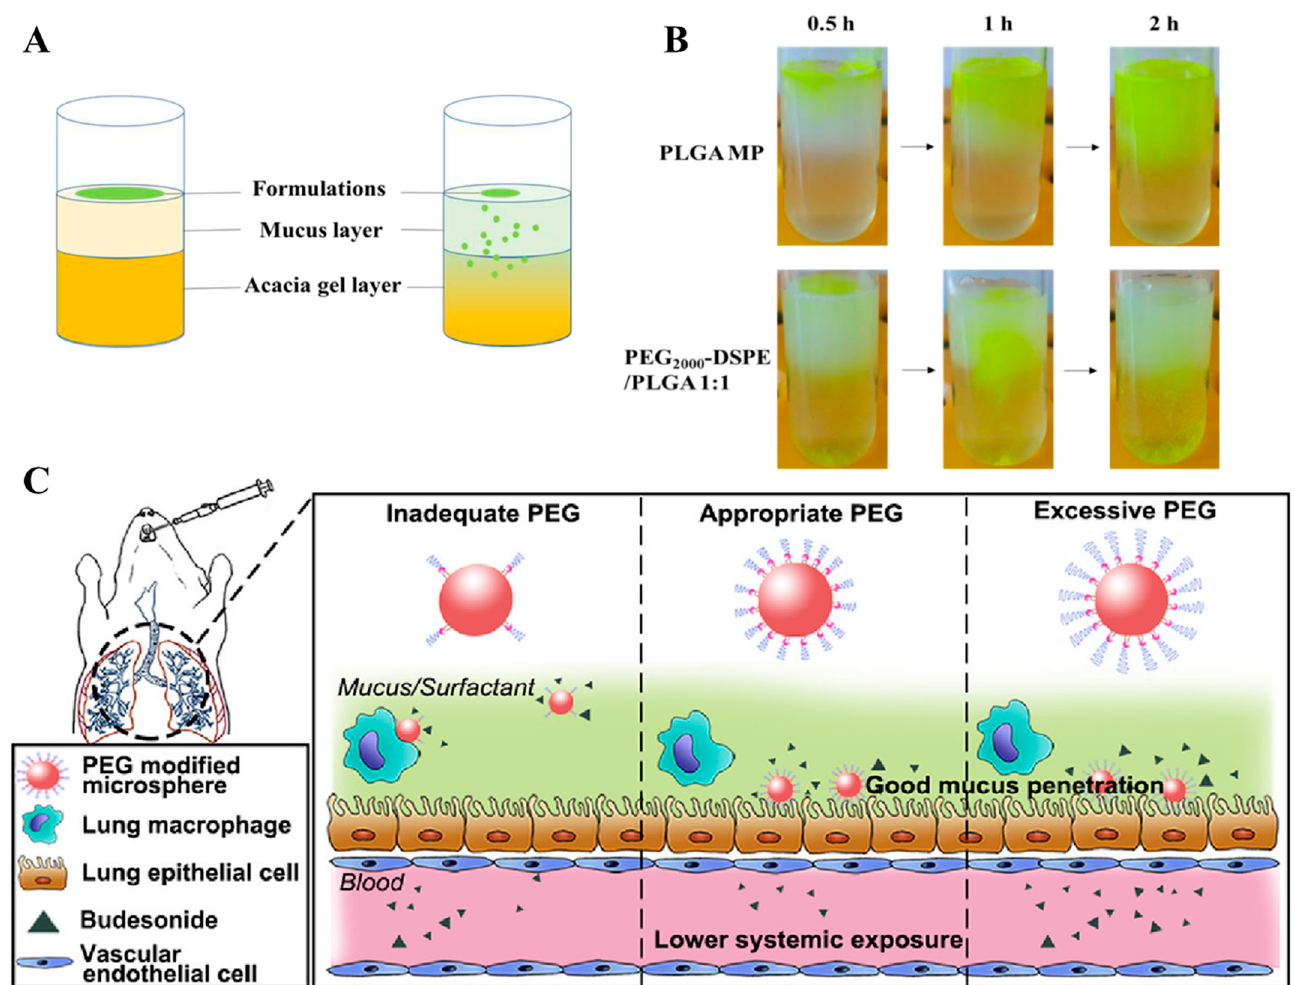
Figure 6. ( A ) Schematic illustration of the mucus penetration study. ( B ) Mucus penetration visualization of the different sample groups. ( C ) Appropriate or excessive PEG could simultaneously overcome the mucus barrier and macrophage uptake. Reproduced with permission from [50] © 2022 Acta Materialia Inc.